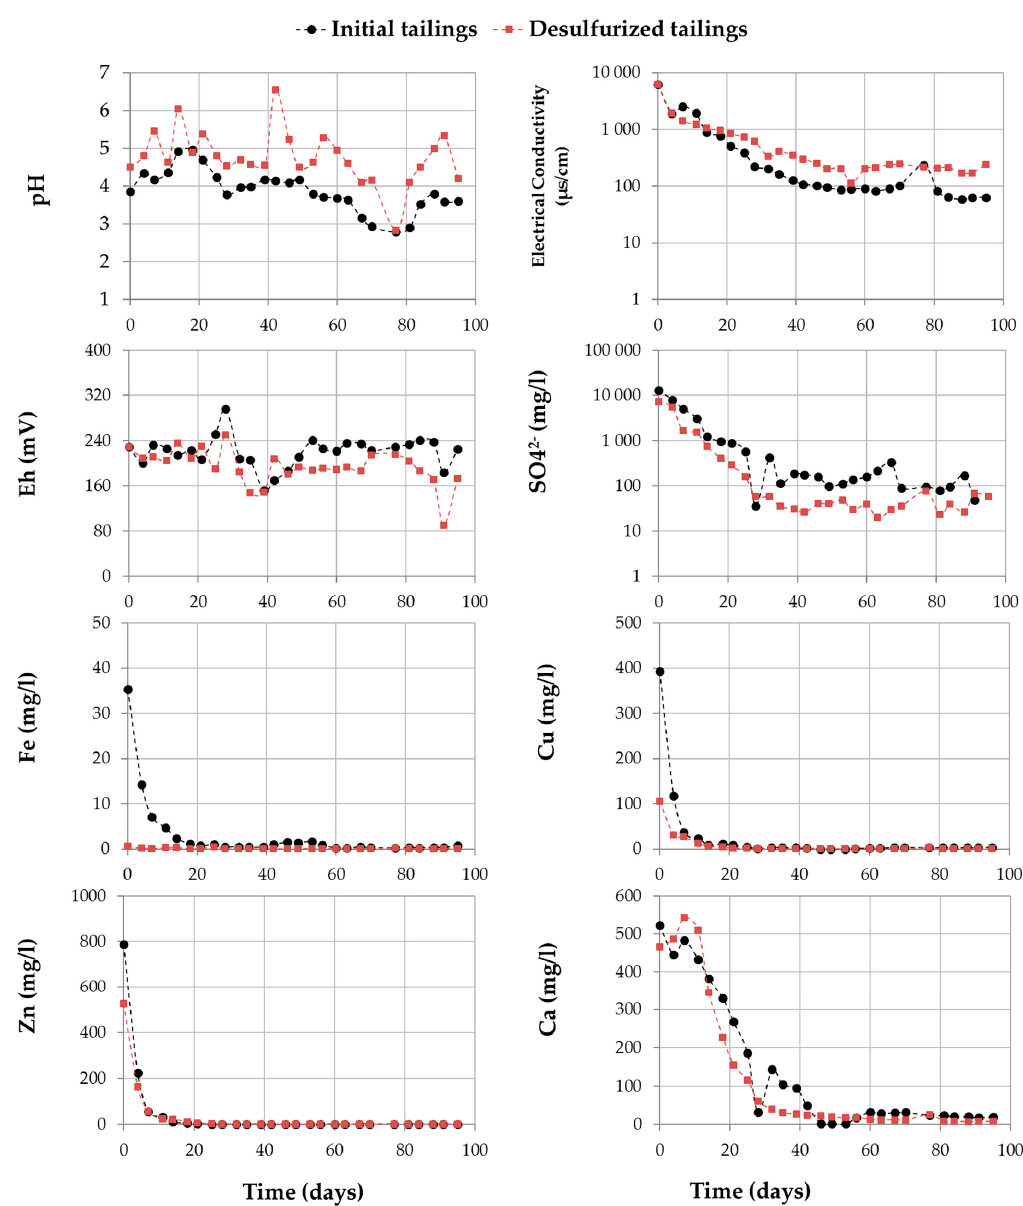
Figure 7. Evolution of pH, Eh, electrical conductivity (EC), and dissolved SO 4 , Fe, Cu, Zn, and Ca in leachates after 27 kinetic test cycles.